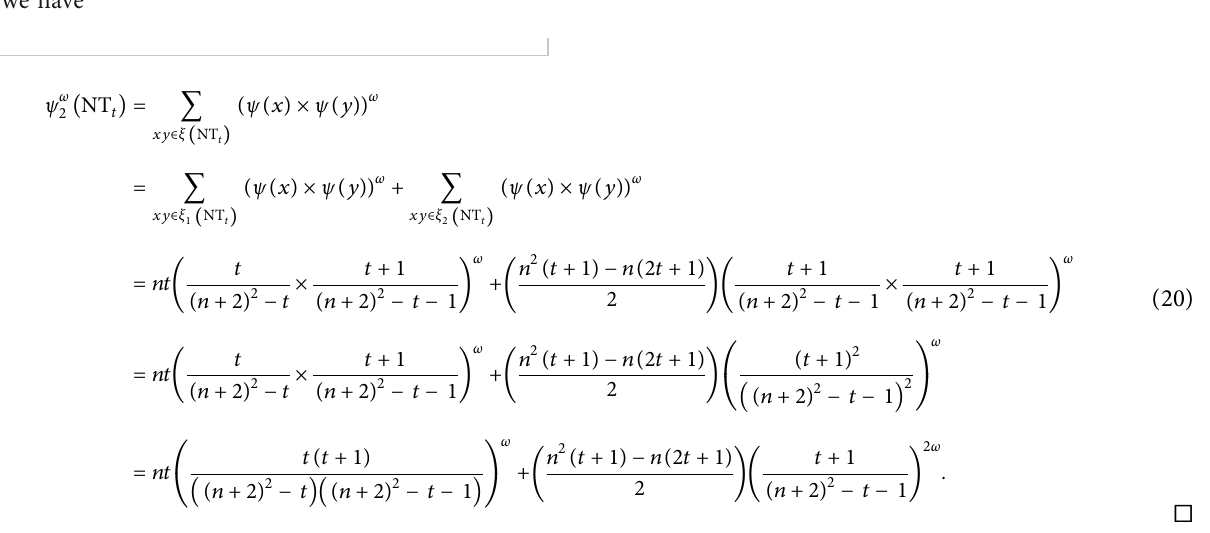
Figure 4: Comparison of ψ ω